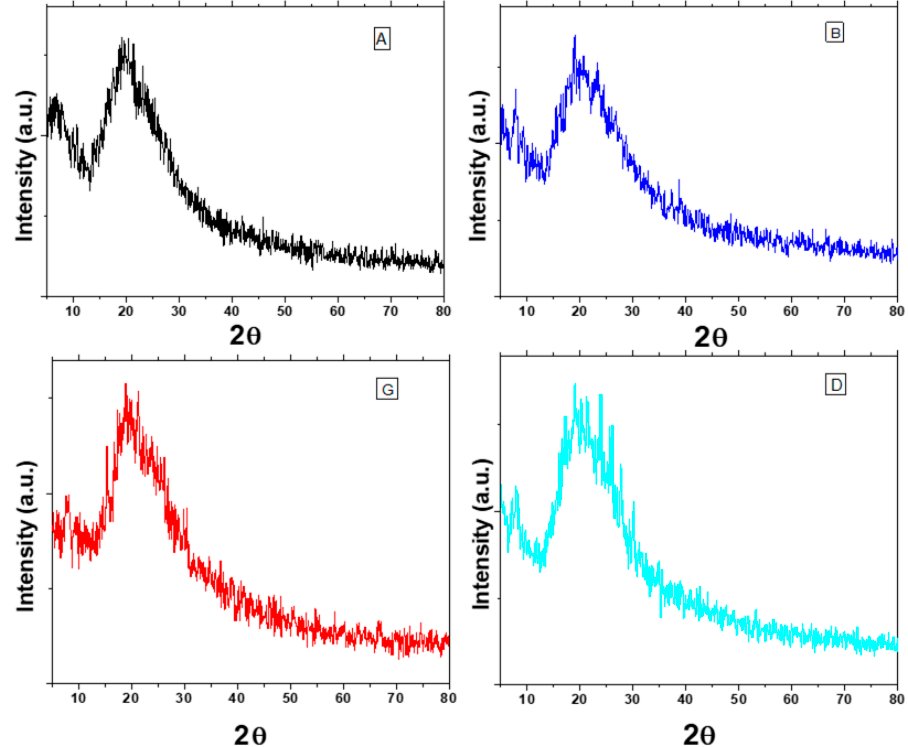
Figure 5. PXRD patterns of different PDG-g-PANI optimized products. (A) optimized with respect to aniline, (B) optimized with respect to BPO, (G) optimized with respect to gum and (D) optimized with respect to